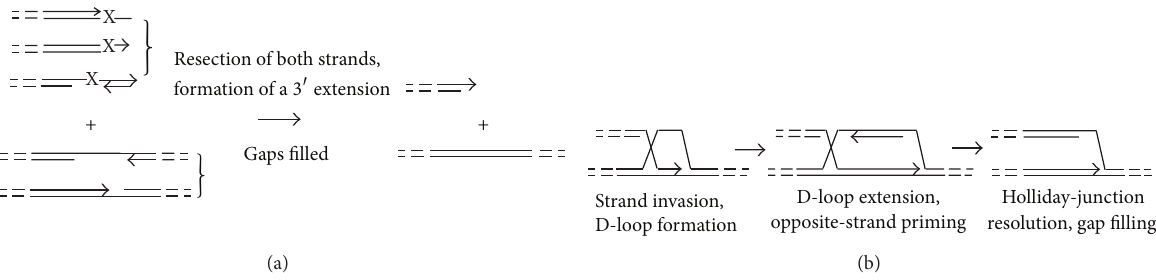
Figure 5: Regeneration of broken replication forks by HR functions. (a) The products of archaeal replication fork breakage proposed in Figure 2 are expected to retain various lesions, gaps, and overhangs; possible structures are illustrated to the left of each bracket. These various structures must be converted to a “clean” 3 󸀠 extension on the ds end and an intact continuous duplex with which it can recombine. (b) Proteins of double-strand-break repair (homologous recombination) promote subsequent reassembly of the replication fork. The steps depicted here are those commonly proposed for bacteria and eukaryotes [37, 38, 52]. As in previous figures, broken lines indicate the remainder of the chromosome, and arrowheads mark 3 󸀠